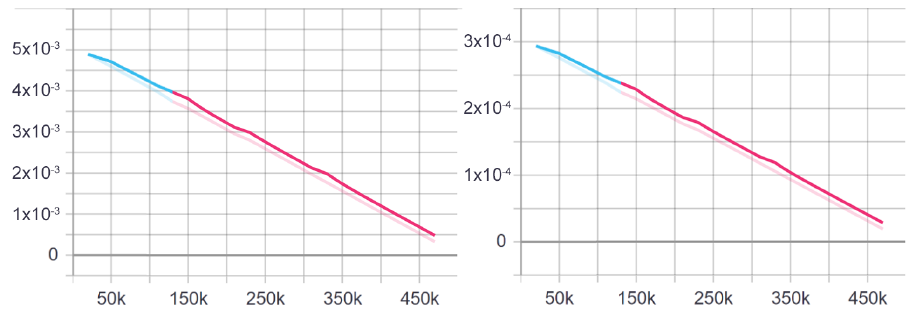
Figure 4. Beta ( left ) and learning rate ( right )